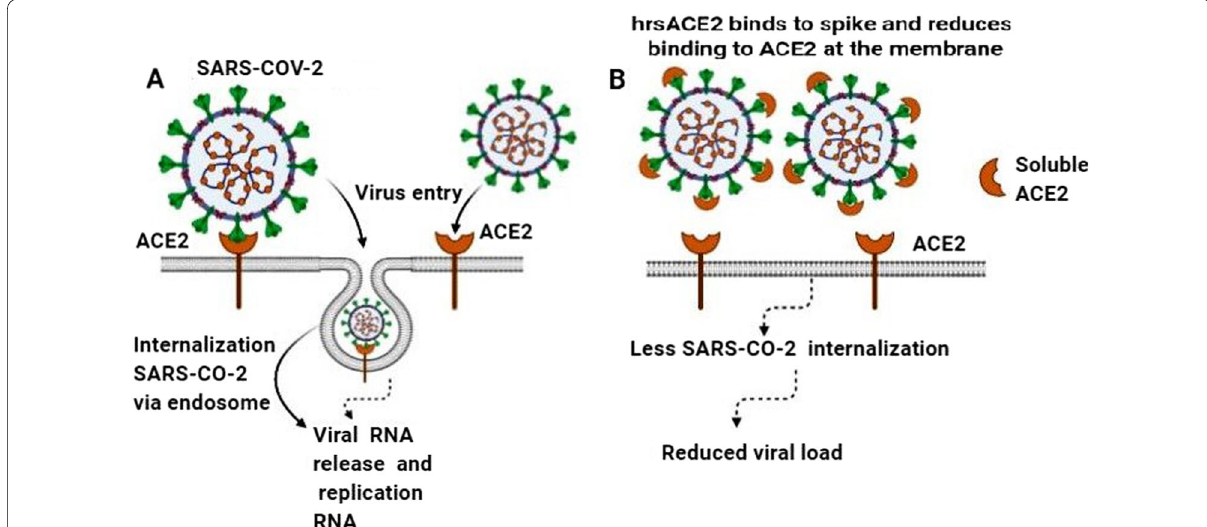
Fig. 4 hrsACE2 inhibits SARS COV-2 replication. A SARS-CoV-2 by spike protein directly binds to the ACE2 receptor and then inter to the host cell by endocytosis. B The covering of SARS-CoV-2 spike protein by hrsACE2 lead to the prevention of the interaction between SARS-CoV-2 and ACE2 and subsequently prevents SARS COV-2 replication in the host